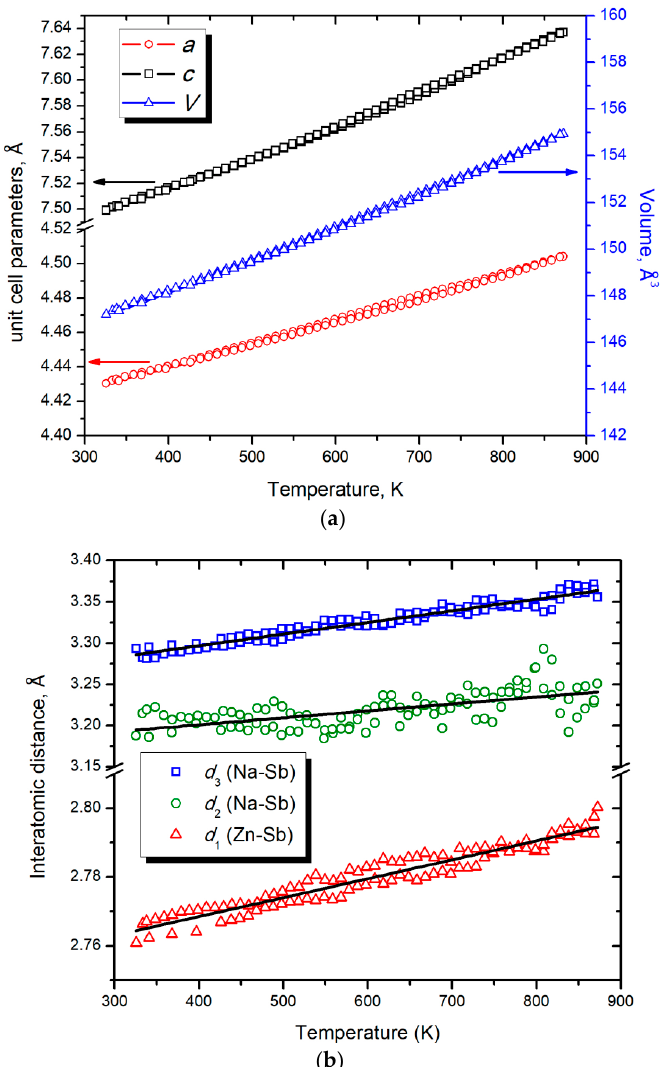
Figure 3. ( a ) Temperature dependence of unit cell parameters ( a and c ) and unit cell volume ( V ) for NaZnSb; ( b ) Temperature dependence of the selected interatomic distances in the structure of NaZnSb: d 1 (Zn–Sb), d 2 (Na–Sb), and d 3 (Na–Sb) (see Figure 1). The black lines correspond to the linear fit of the data.